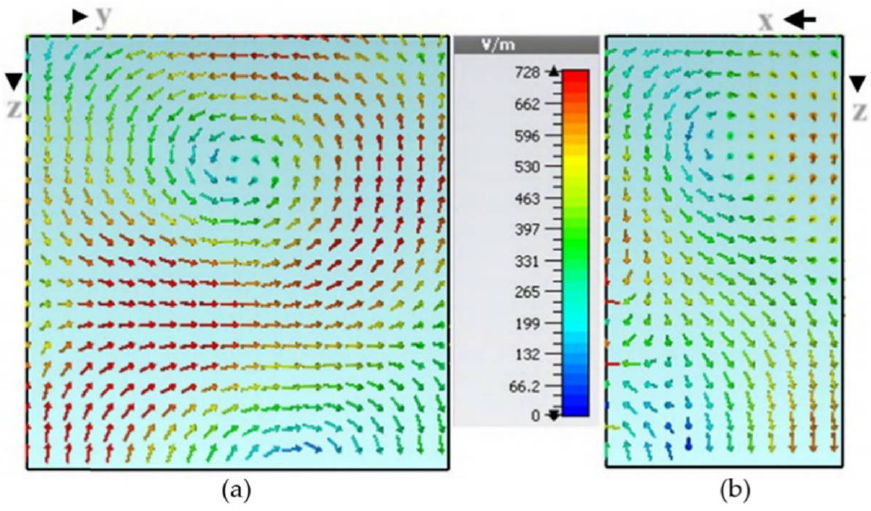
Figure 8. Division of electric field ( a ) TE xδ13 at 3.74 GHz and ( b ) TE y1δ3 at 4.4 GHz.